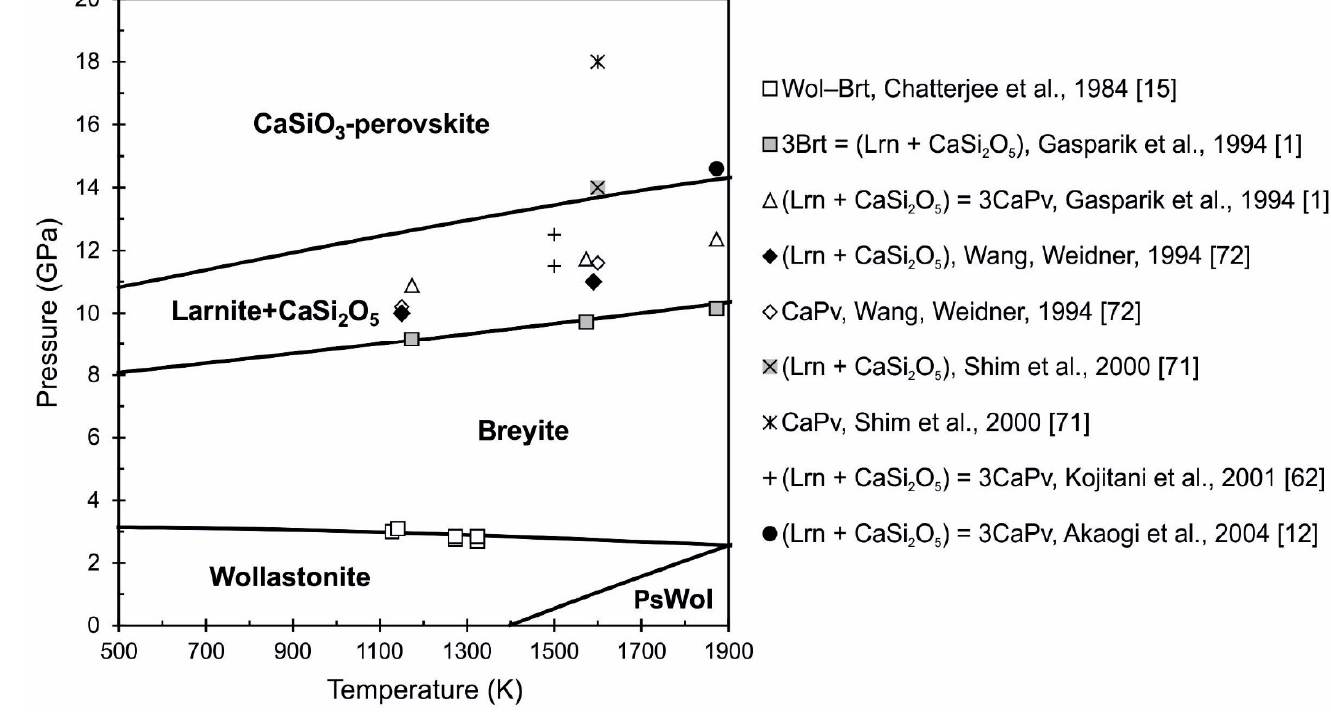
Figure 6. Calculated phase diagram of the CaSiO 3 system under upper mantle P-T conditions. Thick black lines are our calculations, symbols show the different experimental studies. The phase equilibria in the CaSiO 3 system were studied in [1,12,15,62] and stability field of mineral association (Lrn + CaSi 2 O 5 ) and Ca-perovskite in [71,72].